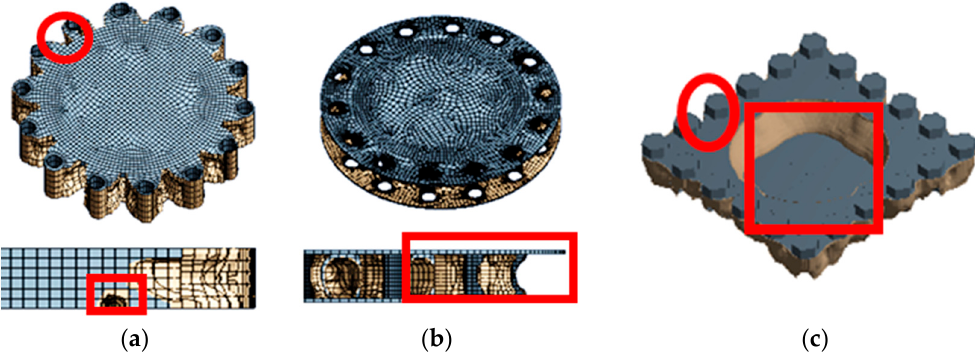
Figure 4. Topology optimization results of conventional end plate of ( a , b ) circular end plate and ( c ) square end plate.